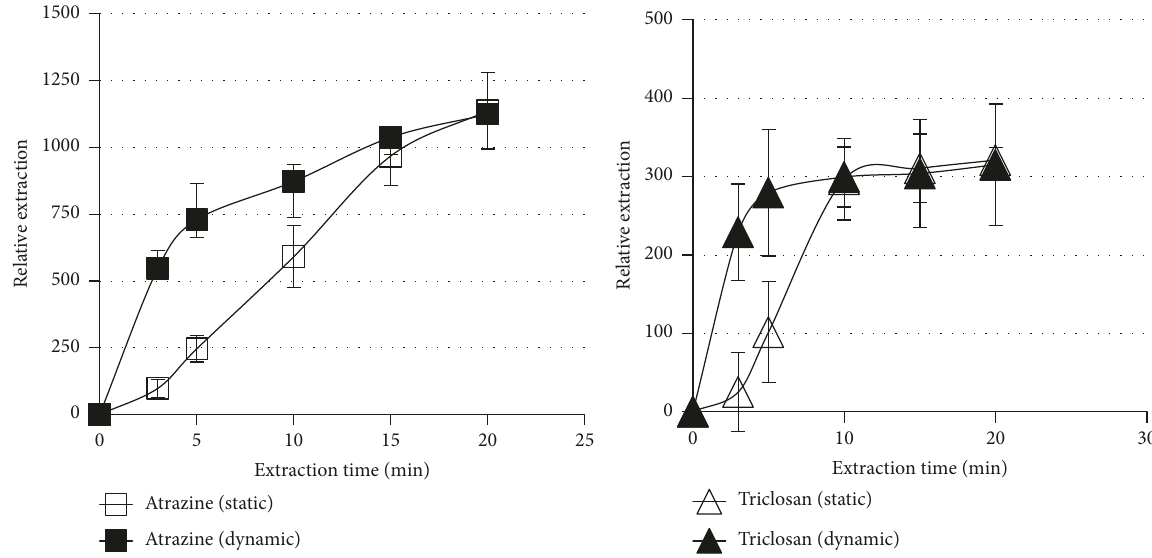
Figure 6: The extraction-time profile for the two analytes with and without stirring. The extraction-time profile of triclosan under the optimised extraction conditions: volume, 1mL of 5 𝜇 g/mL atrazine and triclosan aqueous sample to which 15mg NaCl was added (15% w/v);